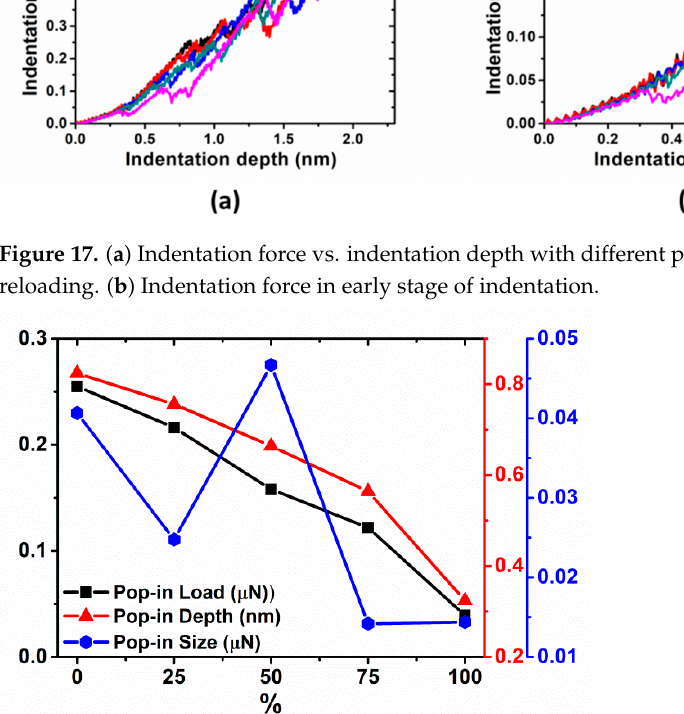
Figure 19. Snapshots of initial atomic structures and distributions of dislocations before indentations at various strain level ( a1 , a2 ) 0%, ( b1 , b2 ) 25%, ( c1 , c2 ) 50%, ( d1 , d2 ) 75%, and ( e1 , e2 ) 100%. 4. Conclusions Through large scale MD simulations, nanoindentation of fcc single crystal Cu by a spherical indenter are performed to explore the coupled effects of prestrain, the presence of resulting dislocations and surface morphology, and indenter size on the mechanical response in Cu substrate. We find that two types of indentation size effects are reproduced in defect-free crystals and the trends of indentation hardness and maximum shear stress are consistent. During the indentation process, the total energy change is more sensitive to plastic deformation than the load change, implying that the indenter force is not a reli- able indicator of the onset of plasticity. Instead, the total energy of the system is a better indicator. Moreover, we find that in the elastic range, the nucleation of partial dislocations is much easier in prestrained samples due to a lower activation energy and larger activa- tion volume without the presence of pre-existing dislocations. Plasticity can be initiated either by the activation of pre-existing mobile dislocations (prestrain = 0.14 and 0.15) or by the nucleation of dislocations (prestrain = 0.3 and 0.4). The latter requires higher stresses than the former. So, we observe that at smaller prestrains (0.14 and 0.15) pop-in